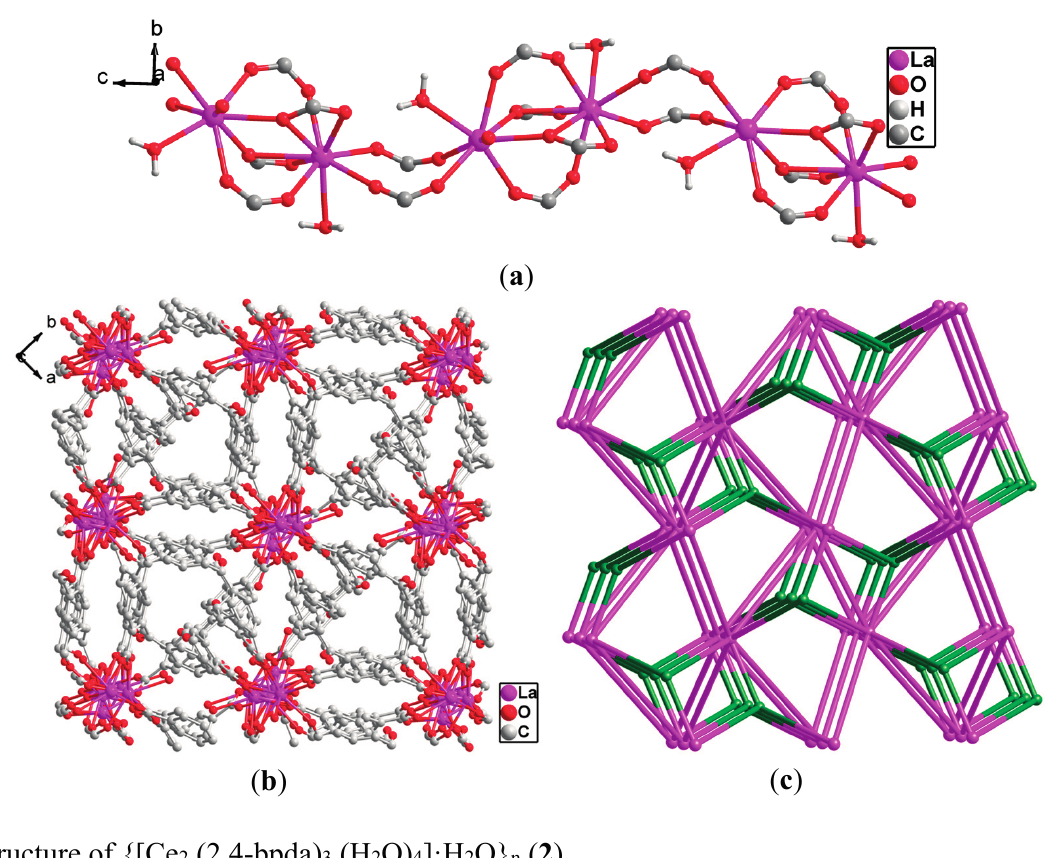
Figure 3. ( a ) View of the 1D [La 2 (COO) 4 (H 2 O) 2 ] chain SBUs along the c axis; ( b ) View of the complicated 3D framework of 1 along the b axis. All H atoms are omitted for clarity; ( c ) Schematic description of a new 2-nodal (3,7)-connected topology with a point symbol of (4 2 ·5) (4 4 ·5 1 ·6 6 ·8), constructed from the 3-connected 2,4-H 2 bpda 2 − and